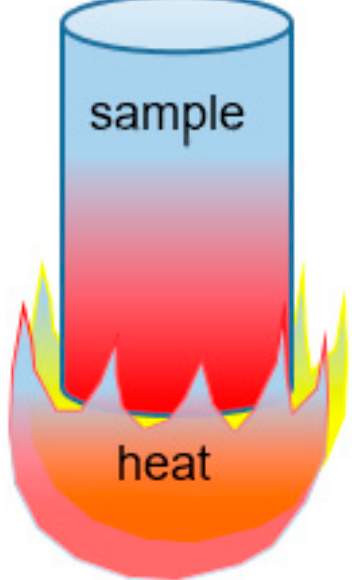
Figure 1. Sample with heat flux at one end.